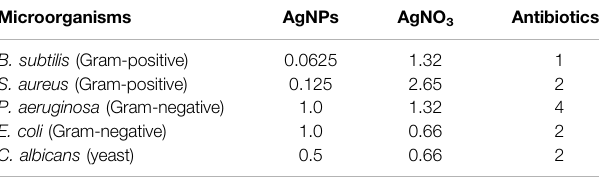
TABLE 2 | MIC results of AgNPs, AgNO 3 , and standard antibiotics ( μ g/ml). Microorganisms